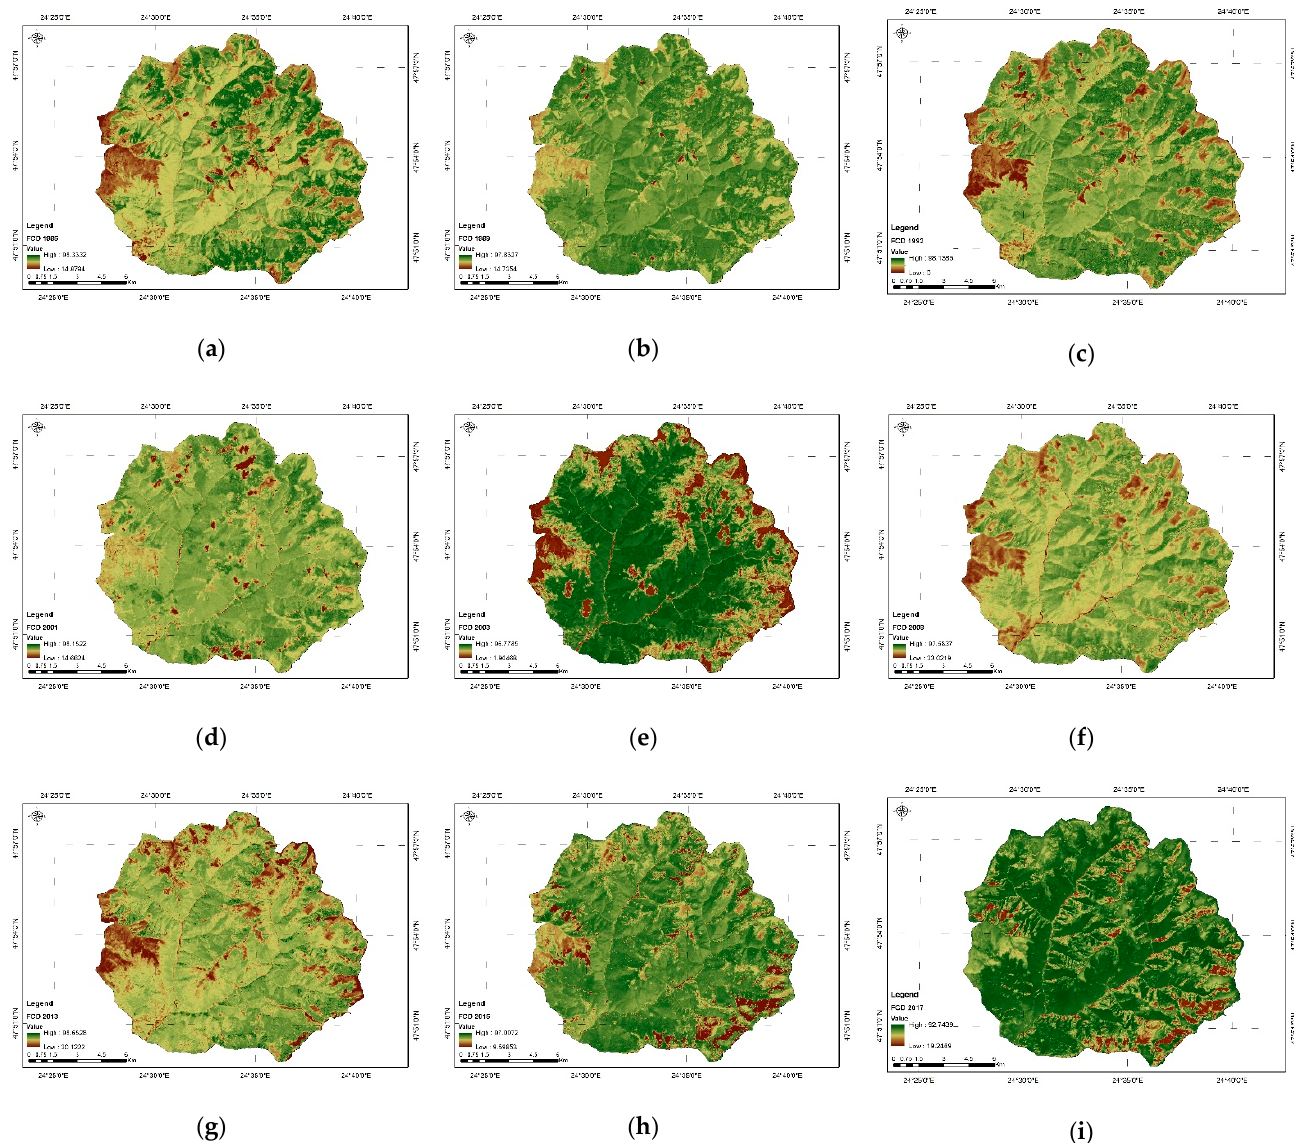
Figure 12. FCD index extracted from satellite images. ( a ) FCD 1985; ( b ) FCD 1989; ( c ) FCD 1992; ( d ) FCD 2001; ( e ) FCD2003; ( f ) FCD 2008; ( g ) FCD 2013; ( h ) FCD 2015; ( i ) FCD 2017.